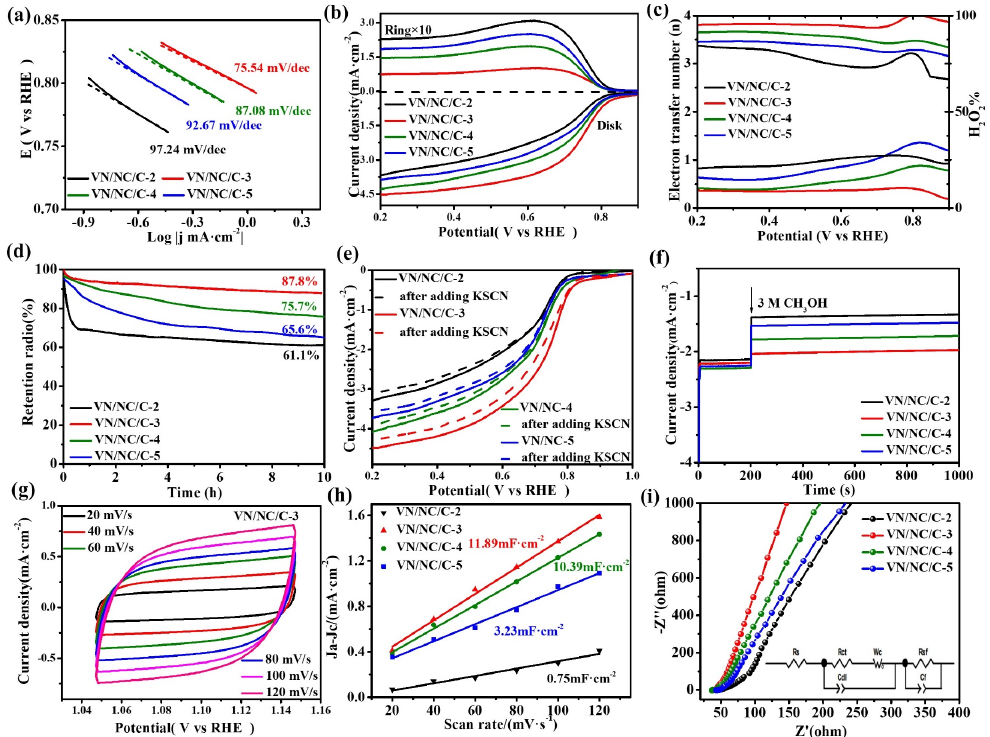
Figure 4. ( a ) Tafel plots of the various catalysts. ( b ) The RRDE data of the VN/NC/C-x. ( c ) The hydrogen peroxide yield and the electron transfer number. ( d ) ORR chronoamperometric responses after adding methanol of the VN/NC/C-x. ( e ) Current–time (i-t) curves of the VN/NC/C-x. ( f ) The effect of the KSCN interaction on the catalytic activity of VN/NC/C-x. ( g ) The voltammograms of VN/NC/C-3 at different scan rates. ( h ) Δ j fit of VN/NC/C-x ( Δ j = j a − j c ) versus scan rate (vs RHE) at the set potential. ( i ) Nyquist plots of VN/NC/C-x, the inset shows the equivalent circuit.